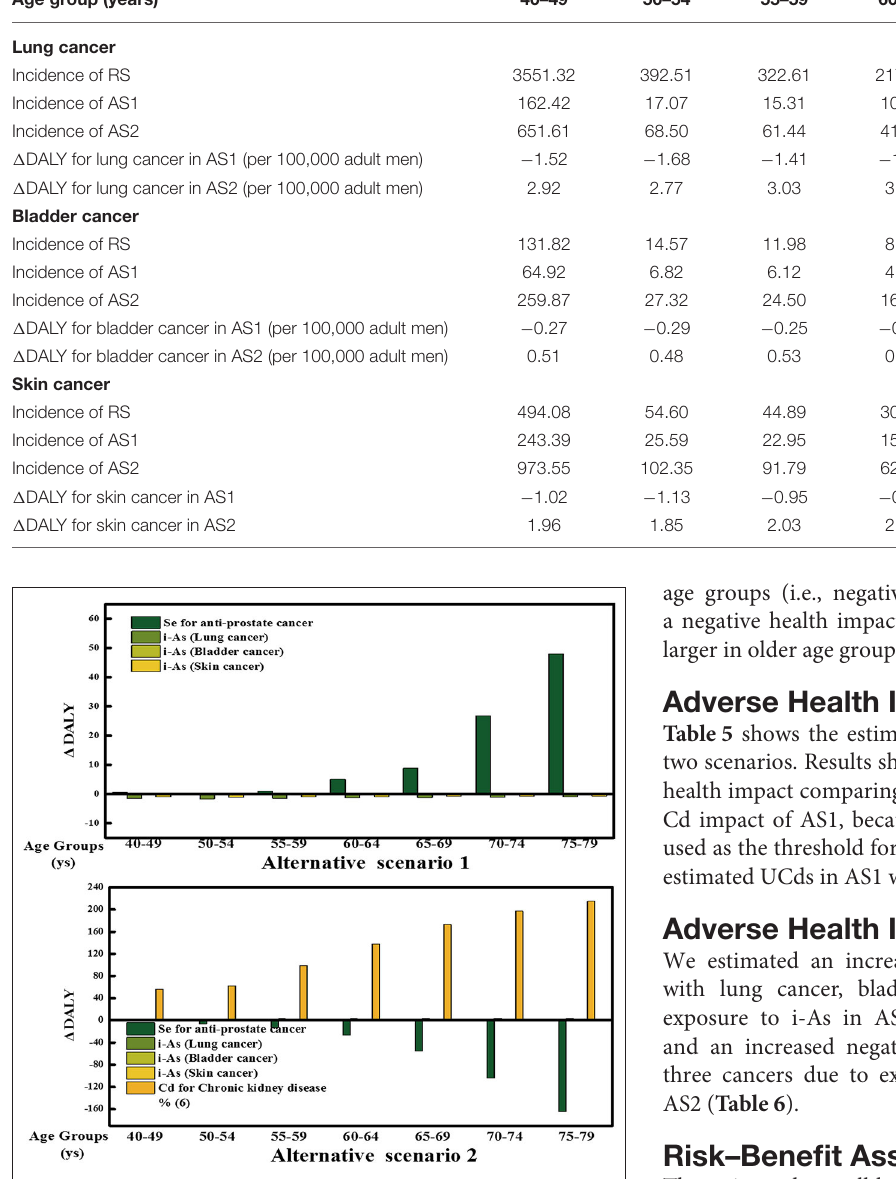
individual health